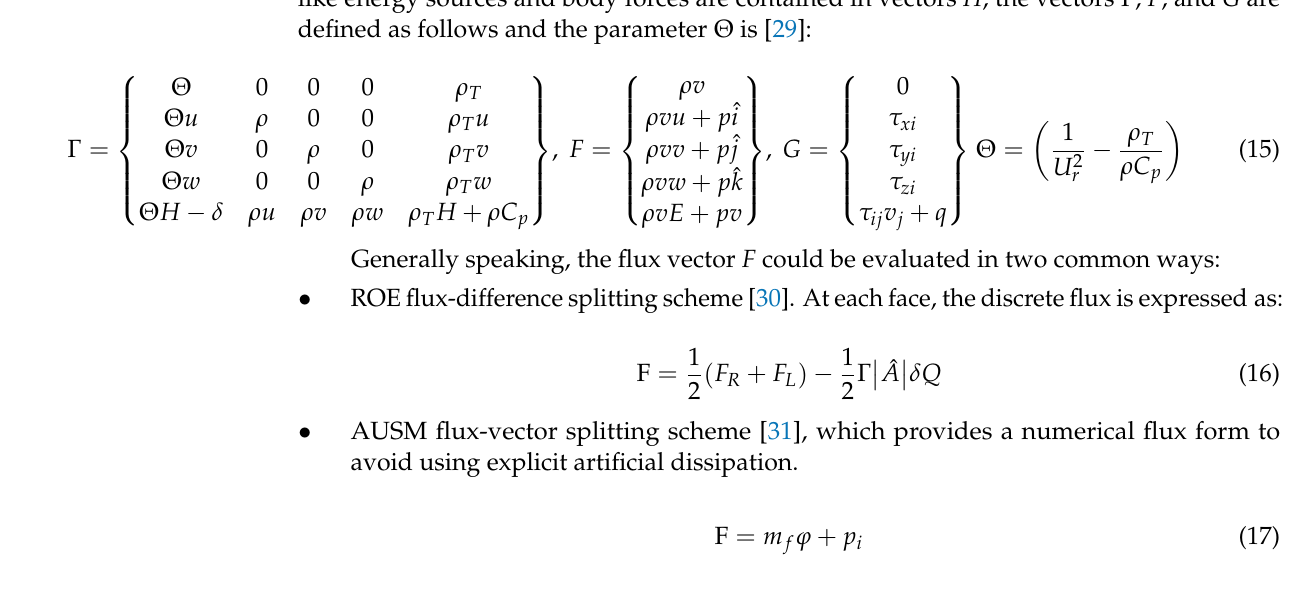
Table 7. Comparison between numerical results of the first-order upwind and second-order upwind of the Modified turbulent